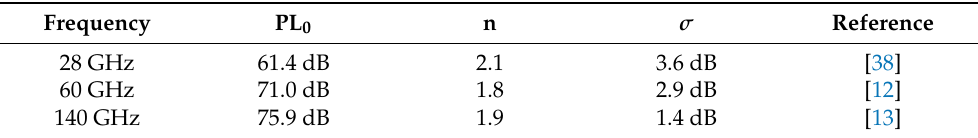
Table 1. One-slope path loss (PL) model parameters for different frequencies, with reference distance d 0 = 1